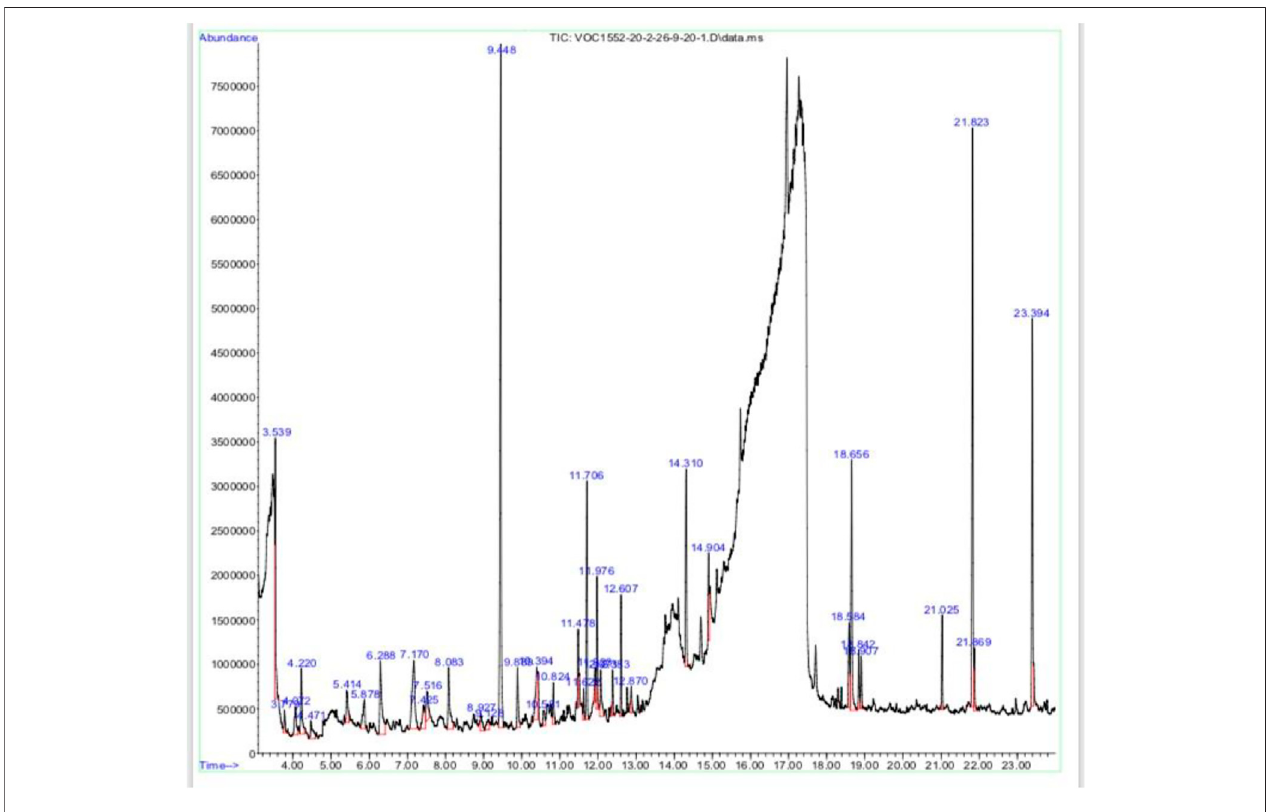
FIGURE 2 | GC-MS analysis of Viola odorata methanolic